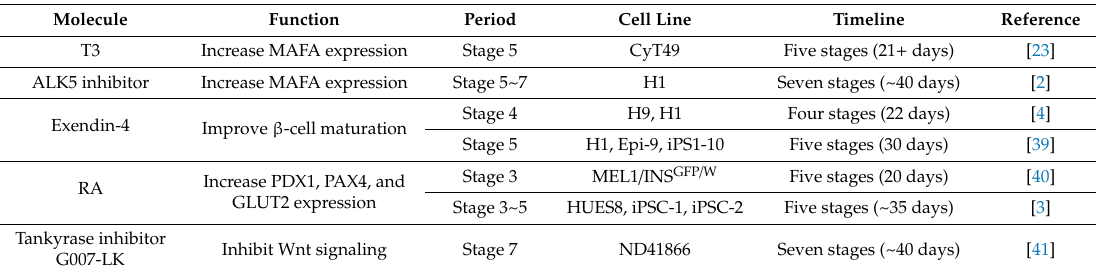
Table 1. Molecules that promote the maturation of β -cells.